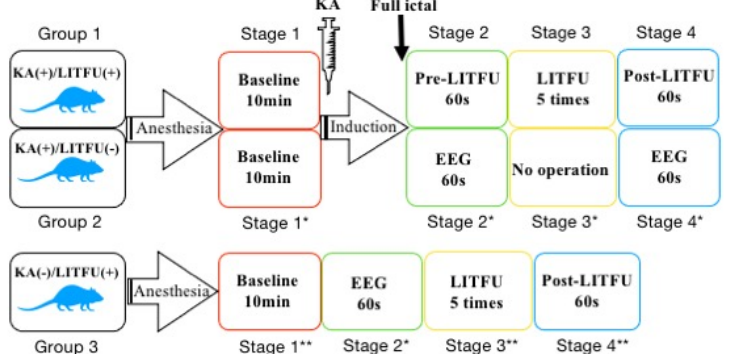
Figure 5. Experimental flow chart. Stage 1 (Stage 1*/1**) represents the baseline period. The baseline EEG was recorded for ten minutes after the EEG signals stabilized following the administration of anesthesia. Stage 2/2* (named as ‘Pre-LIFU’) in Group 1 and Group 2 indicate the time-interval after observing significant evidence of ictal behavior (e.g., forelimb clonus and tail-twitches) and just before the sonication. Stage 3/3** in Group 1 and Group 3 represent the 5 times of the sonication (named as ‘LIFU’). There was no operation in Stage 3 * of Group 2. Stage 4/4** represents the time-interval after the sonication. Stage 4 * in Group 2 represents the EEG data corresponding to the time of the other two groups.